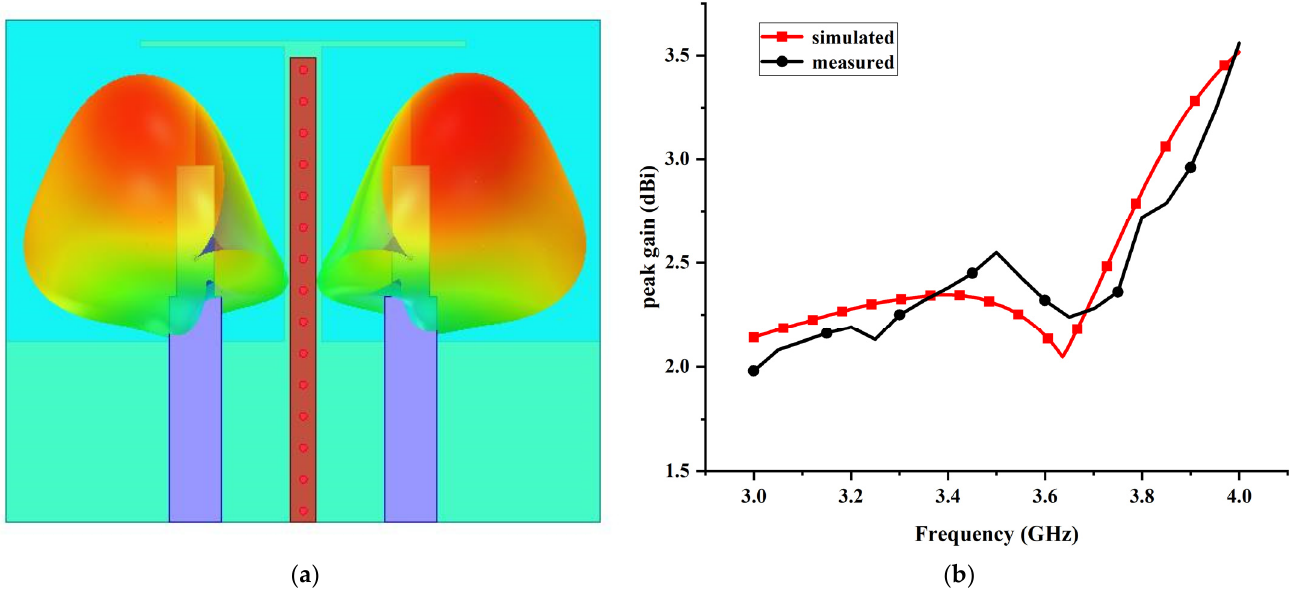
Figure 20. ( a ) The simulated 3D radiation pattern at 3.45 GHz; ( b ) the simulated and measured re- alized peak gain.